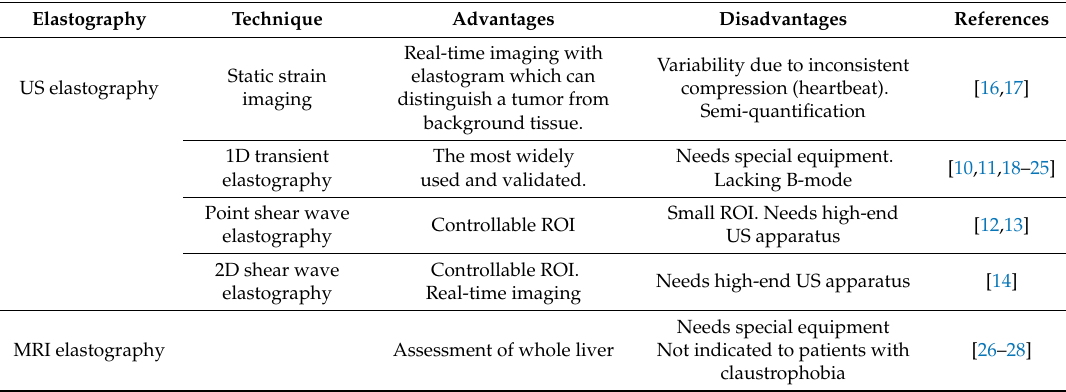
Table 2. Characteristics of